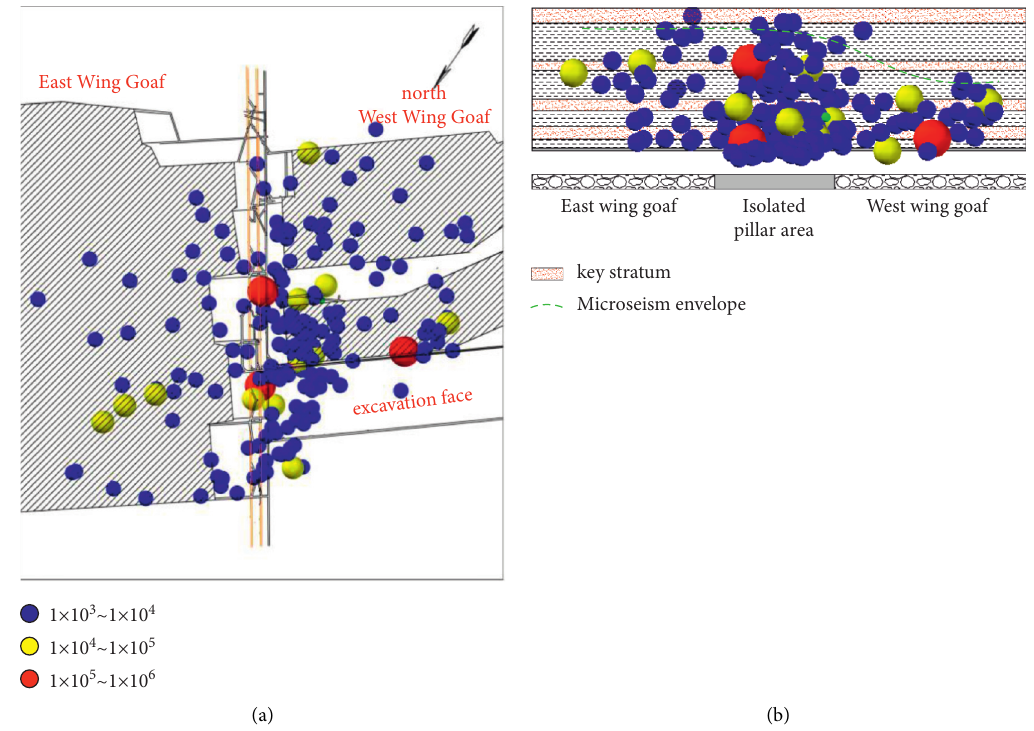
Figure 4: Microseismic localization map of the asymmetric isolated coal pillar area (2018.01.01 ∼ 2018.06.30): (a) microseismic positioning plan; (b) microseismic positioning orientation